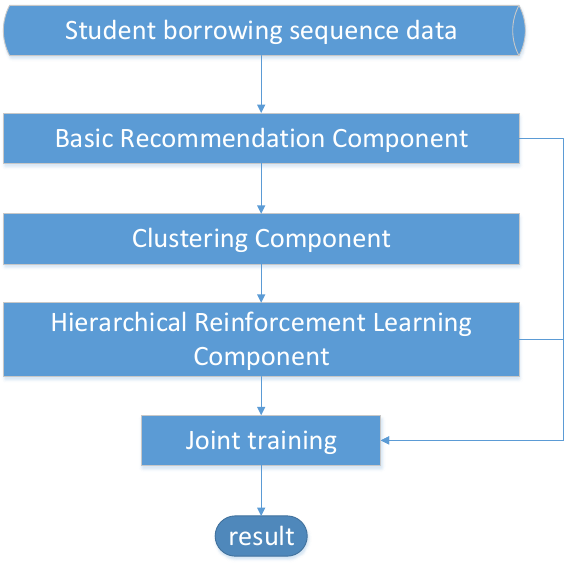
Figure 2. The workflow of our CHRL